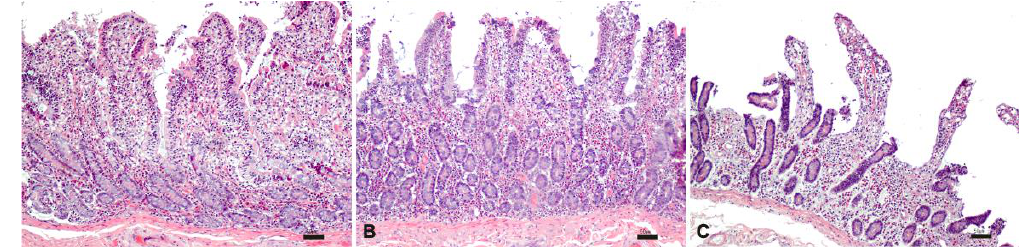
Figure 7. Histological evaluation of intestinal tissue stored at 25°C at 1 h ( A ), 2 h ( B ) and 3 h ( C ). HE; bar: 50 µm.